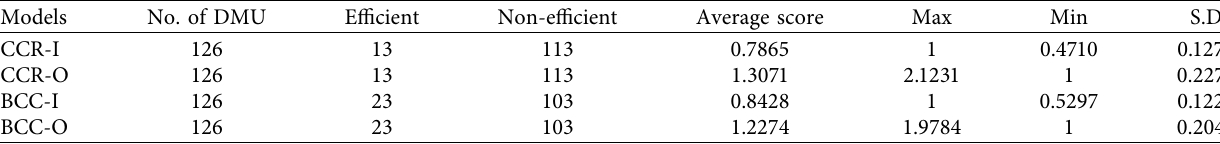
Table 6: Comparison between CCR and BCC models.